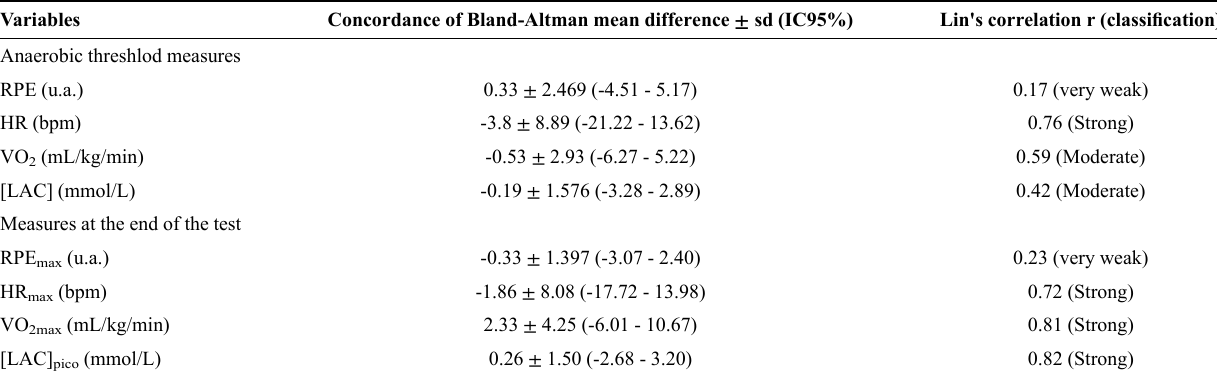
Table 2 - Concordance of Bland-Altman and Lin's correlation between ergometers (n = 15). Variables